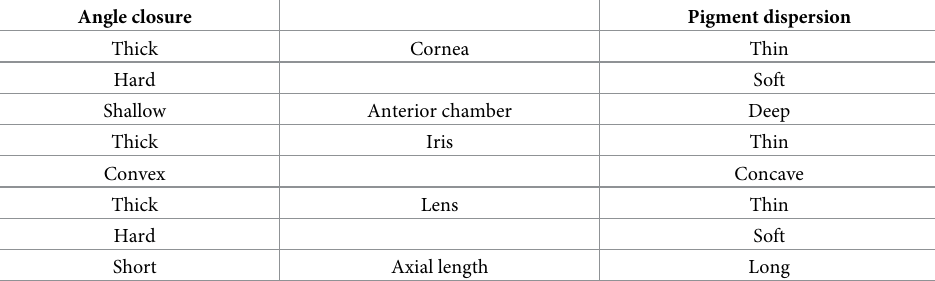
Table 3. Typical ocular biometric features of old hyperopic primary angle closure eyes (left) and young myopic pigment dispersion eyes